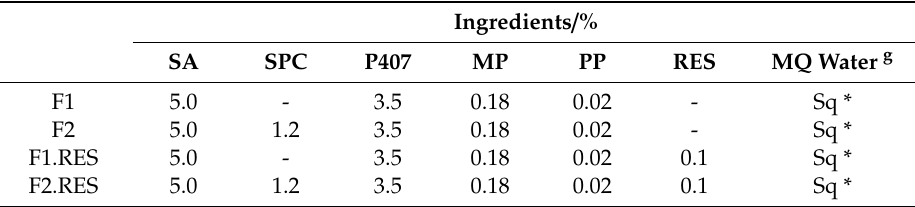
Table 1. Composition of solid lipid nanoparticles (SLN)